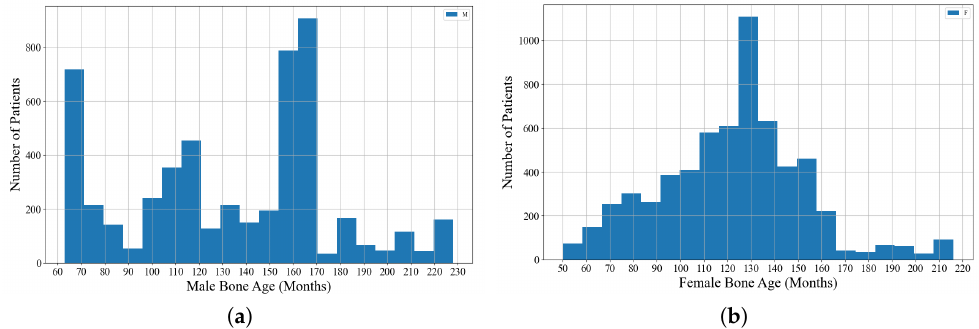
Figure 1. The distribution of examples in this dataset based on the ground truth bone age. ( a ) Age distribution of the male group. ( b ) Age distribution of the female group.